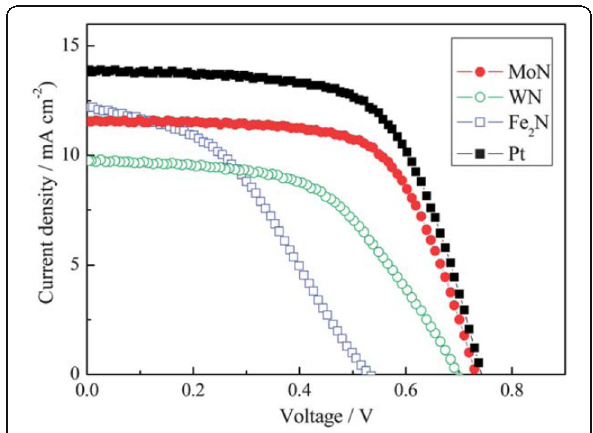
Fig. 6 Characteristic J – V curves of DSSCs using different metal nitrides and Pt counter electrodes, measured under simulated sunlight at 100 mWcm − 2 (AM 1.5)